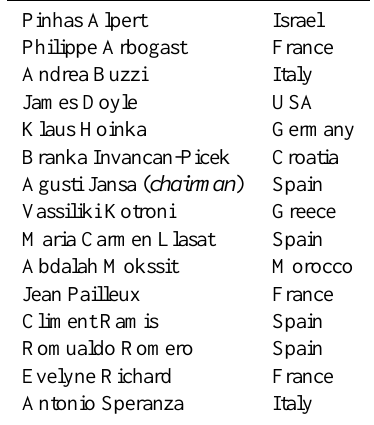
Table A1. Members of the MEDEX Science Steering Committee (at least part of the time during the MEDEX